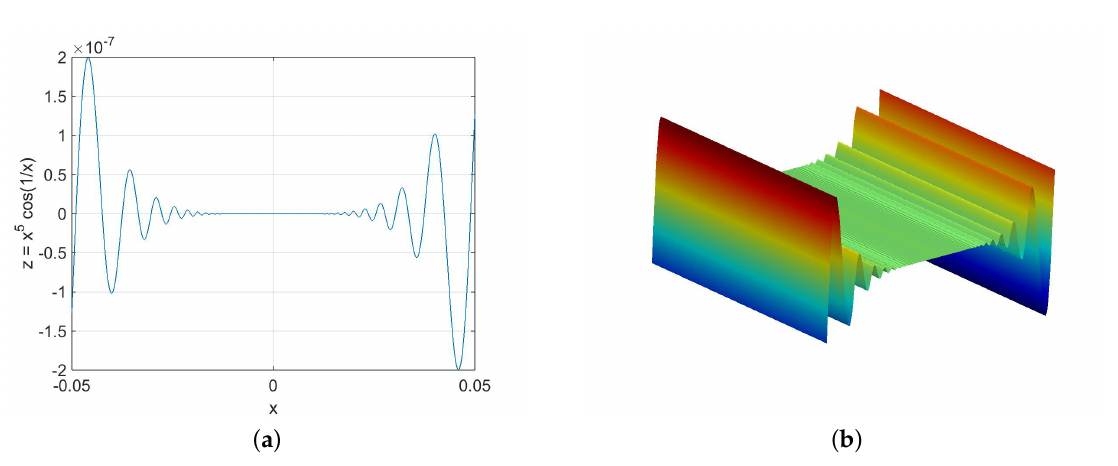
Figure 3. The surface z ( x , y ) = x 5 cos ( 1 one in a bounded region S ⊂ R 3 . ( a ) The function z ( x ) = x 5 cos ( 1 interval ( − a , a ) ; ( b ) Surface z ( x , y ) = x 5 cos ( 1